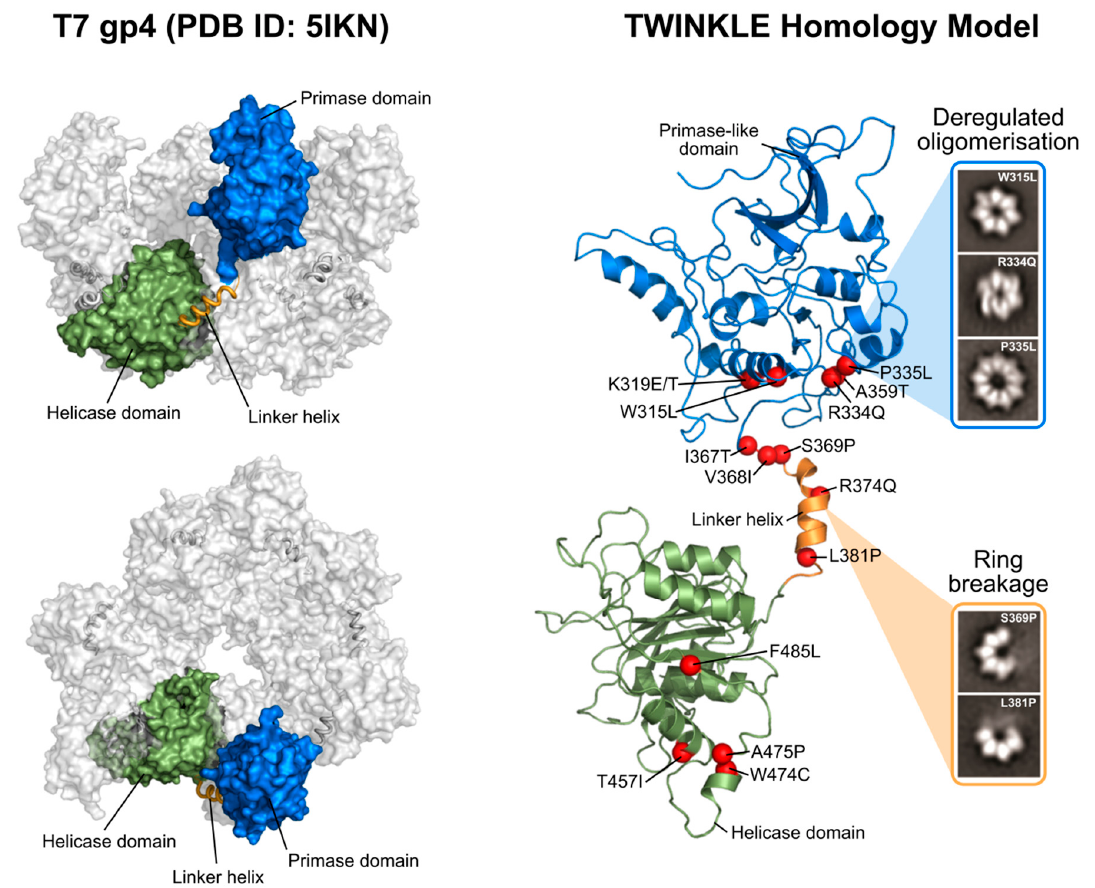
Figure 2. Structure and domain organization of TWINKLE and T7 gp4. ( Left panel ) Top and side views of the heptameric T7 gp4 protein (PDB ID: 5IKN). The helicase (green) and primase (blue) domains as well as the linker helix (orange) are shown. ( Right panel ) Homology model of a TWINKLE monomer comprising a non-functional primase-like domain (blue) connected to a conserved helicase domain (green) by a flexible linker helix (orange). The positions of disease-causing mutations for which in vitro biochemical data is available are shown as red spheres. Single-particle negative stain images are also shown for selected disease variants, highlighting the e ff ects of these mutations on TWINKLE oligomerization.